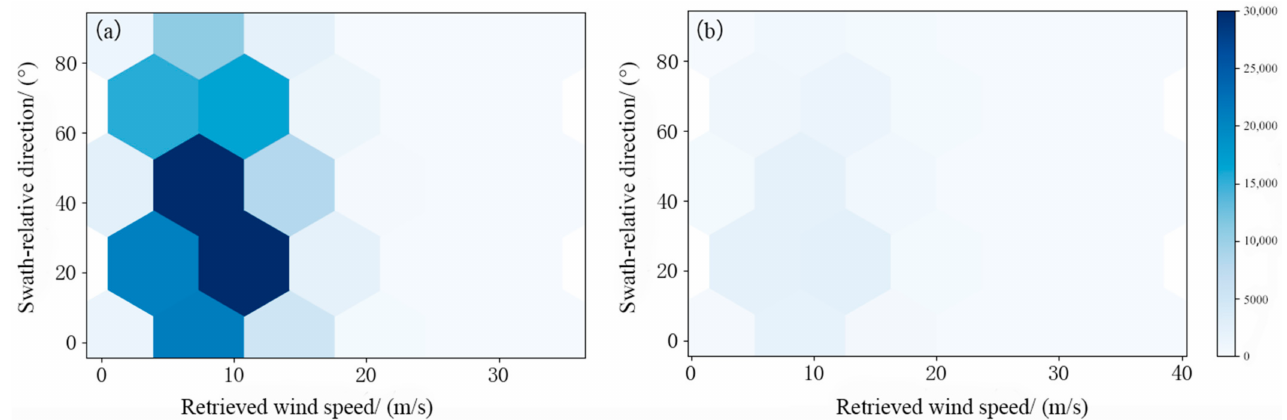
Figure 1. Principle diagram of MUDH technique, taking a two-dimensional histogram as an example. ( a ) The histogram used to accumulate the total number of WVCs; ( b ) the histogram used to accumulate the number of rain-contaminated